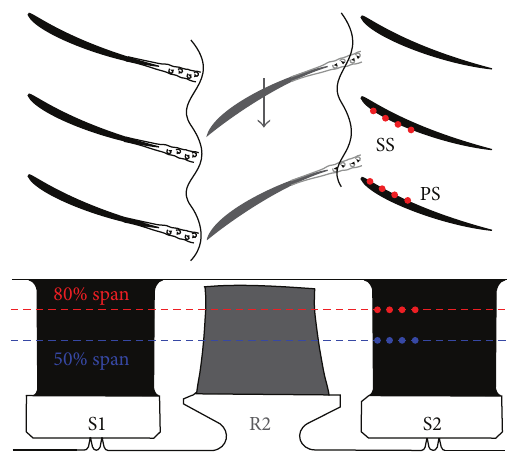
Figure 6: Top-down and side view of Stator 2 with installed pressure